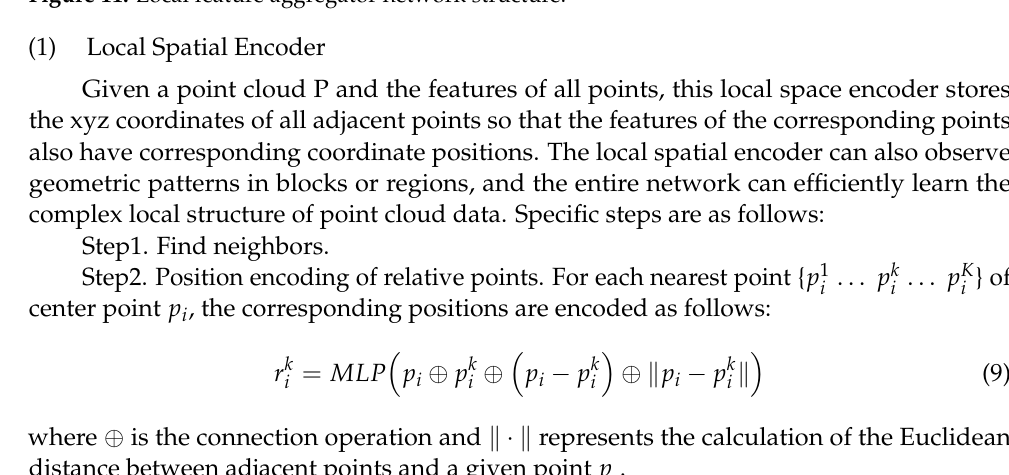
Figure 11. Local feature aggregator network structure.